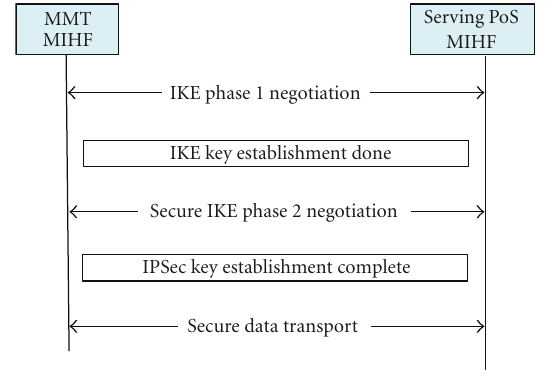
Figure 5: IPSec tunnel establishment.